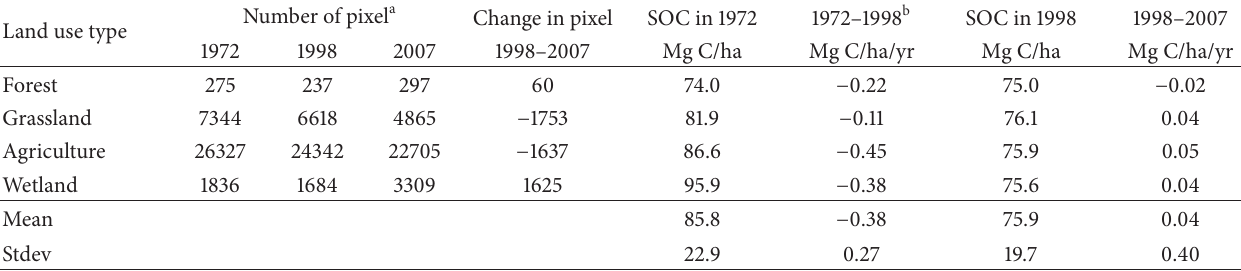
Table 2: The baseline SOC stocks of major land use classes and their change rates.